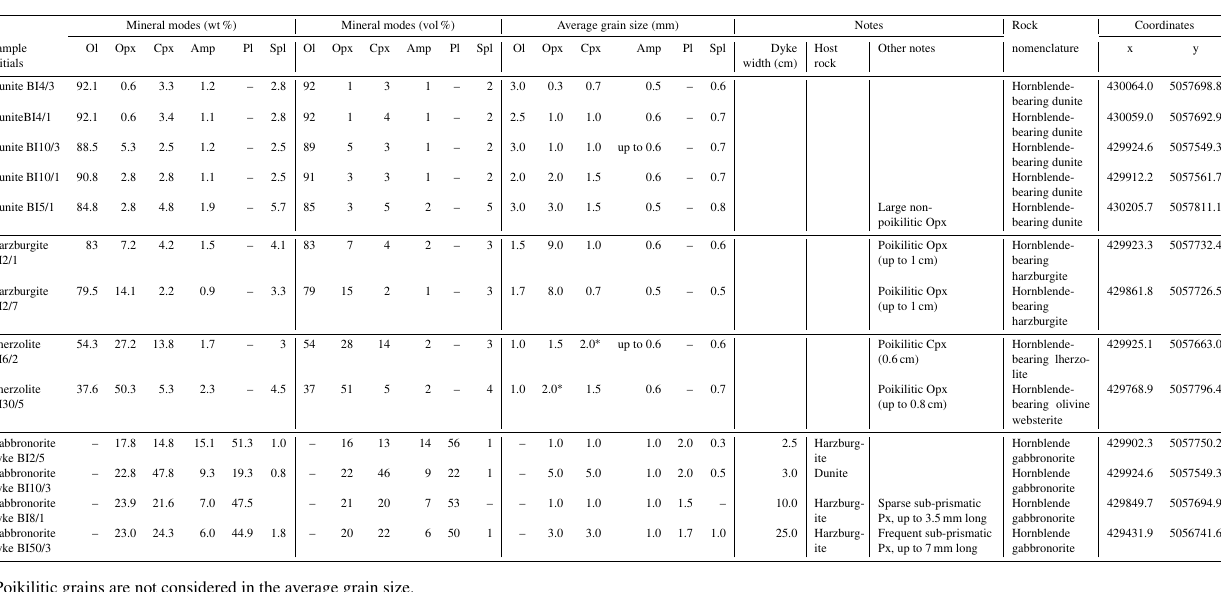
Table 9. Location and main petrographic characteristics of selected samples. Mineral proportion calculations (wt%) were carried out on anhydrous basis, assuming all Fe as Fe 2 + . We used a least squares mixing programme to reproduce the observed whole-rock compositions (Table 1) based on mineral compositions (Tables 2–7). For the peridotites, the best fit between observed and calculated whole-rock com- positions was obtained by refinements based on the following: (i) TiO 2 , CaO and Na 2 O for clinopyroxene and amphibole proportions and (ii) SiO 2 , Al 2 O 3 , NiO and Cr 2 O 3 for olivine, orthopyroxene and spinel proportions. Obtained weight proportions were converted to volume proportions based on mineral densities (olivine = 3.3–3.4gcm − 3 , orthopyroxene = 3.3–3.4gcm − 3 , clinopyroxene = 3.2–3.3gcm − 3 , am- phibole = 3.2gcm − 3 , spinel = 4.0–4.4gcm − 3 and plagioclase = 2.7gcm − 3 ). Mineral abbreviations are after Whitney and Evans (2010), and rock nomenclature follows the classification of the International Union of Geological Sciences.